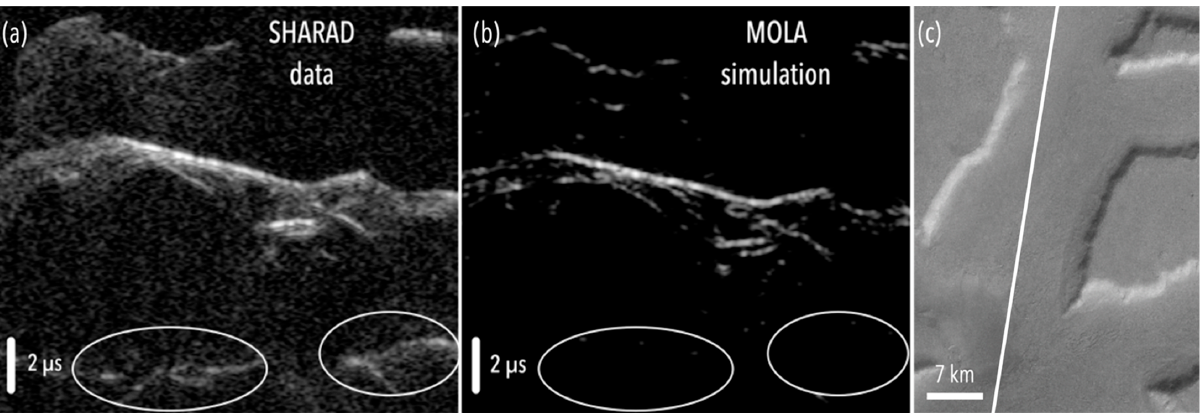
Figure 3. ( a ) A 40 km long portion of the SHARAD profile n°0806502 sounding Deuteronilus Mensae; ( b ) corresponding simulation using a MOLA DTM; ( c ) HRSC image of the terrain at nadir in